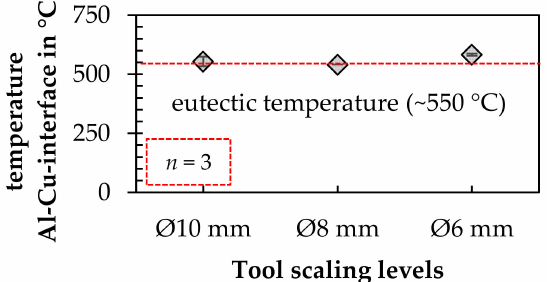
Figure 6. Process temperature at the Al–Cu weld interface for the different tool scaling levels at 2513.3 mm/min circumferential speed and 57.3 N/mm 2 surface pressure.